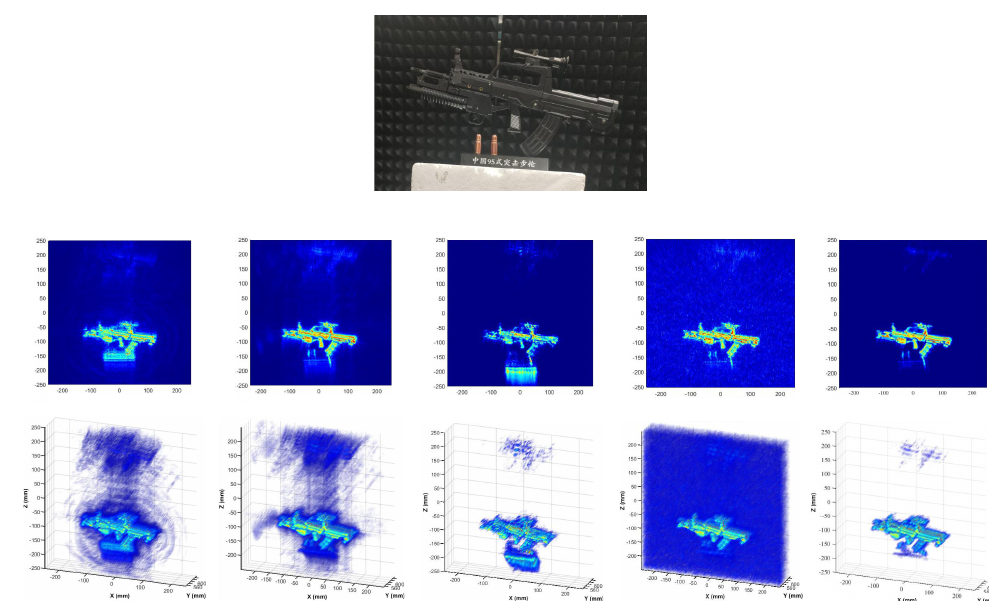
Figure 8. Imaging results in different algorithms. Row 1 is the optical image; Row 2 are 2-D imaging results using different algorithms; Row 3 are 3-D imaging results using different algorithms; Column 1 are the results of BPA; Column 2 are the results of RMA with 100% sampling rate; Column 3 are the results of CSA with 50% sampling rate; Column 4 are the results of RMA with 50% sampling rate; Column 5 are the results of RMIST-Net.